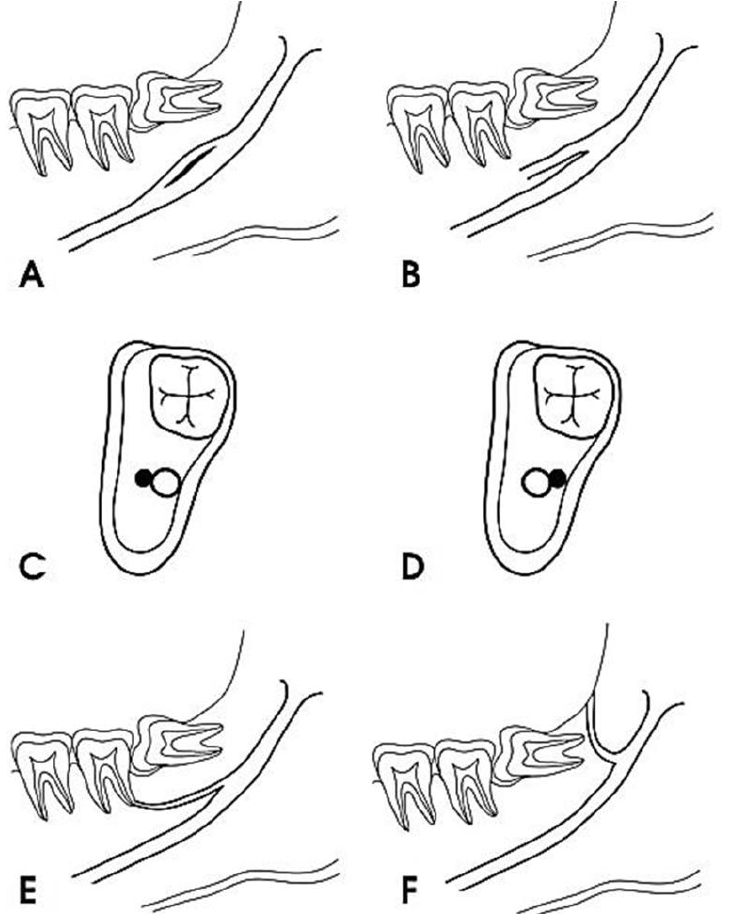
Figure 2. Naitoh classification. The forward canal divided into one with confluence ( A ) or one with- out confluence ( B ). The bucco-lingual canal from the buccal or lingual wall ( C , D ). The dental canal reaches the root apex ( E ). The retromolar canal opens into the retromolar region ( F ). Reprinted with permission from [18] Copyright (2019).